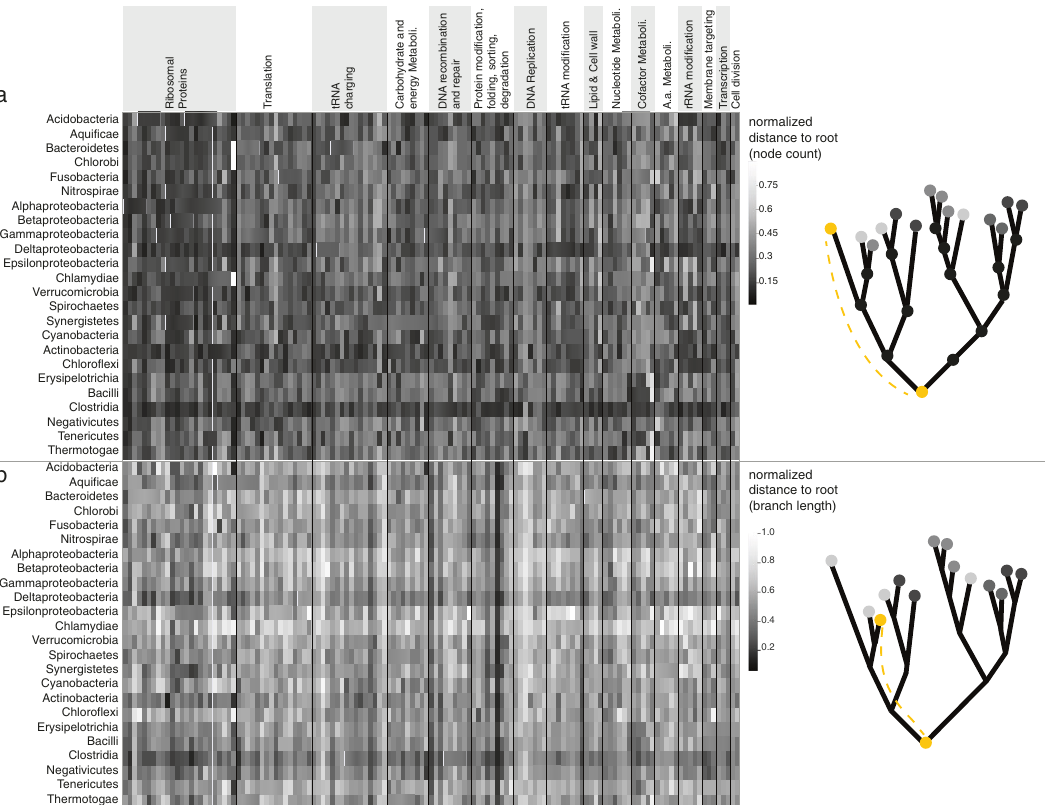
Fig. 2 Divergence analyses for 1089 anaerobic genomes using 131 universal trees reveal clostridial species are closer to the root. Analysis of 131 rooted trees of genes universally present in bacterial anaerobic taxa spanning major functional categories (sorted horizontally according to curated classi fi cations shown on top; order as in Supplementary Data 3). Illustrative trees on the side portray the metric used in each analysis and identify the group at the root in each with yellow nodes. a Root-to-tip distance measured as node depth (normalized by the largest distance in each tree). b Root-to-tip distance measured as branch length (normalized by the largest distance in each